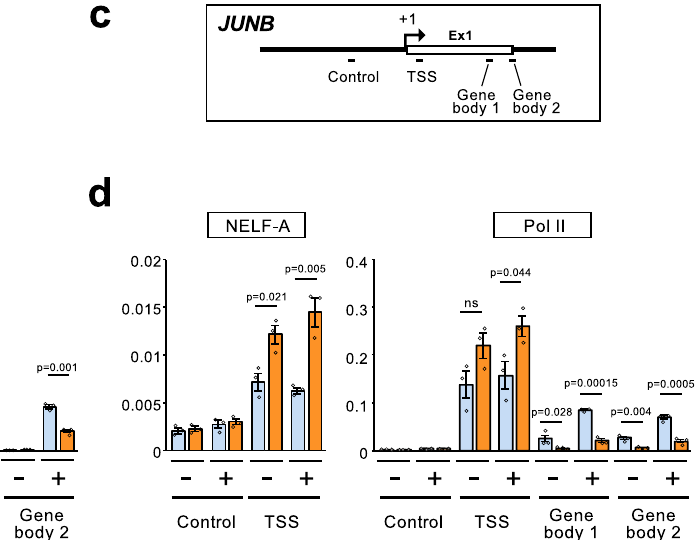
anti-NELF-Aantibody(left)oranti-Pol-IIantibody(right)using chromatin prepared from HEK293-WT or − 4A cells that were simulated with (+) or without ( − ) EGF (20ng/ml for 30min). The densities of NELF-A and Pol-II are presented as % of input. P -values were assessed using a two-tailed Student ’ s t -test. Error bars, SEM ( n =3). Source data are provided as a Source Data fi